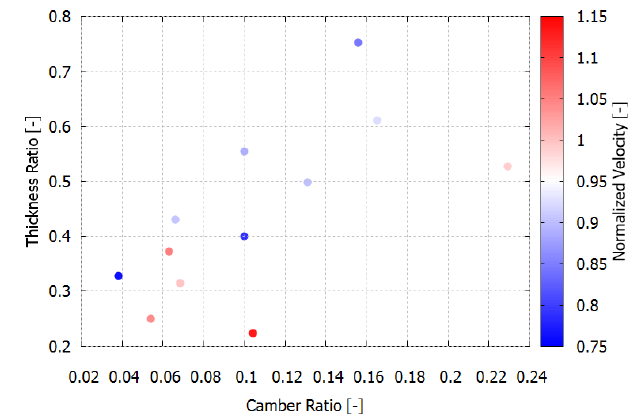
Figure 6. Effect of camber and thickness of the diffuser on the nor- malized velocity at the actuator